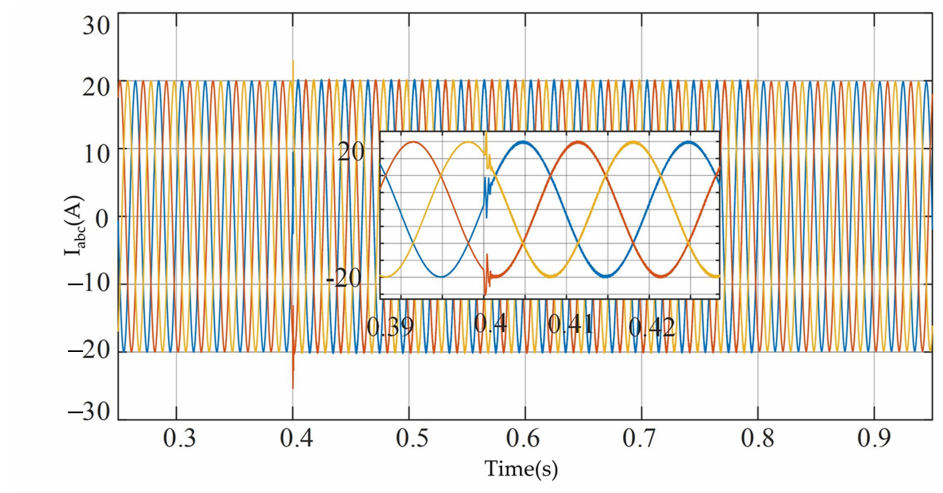
Figure 18. Three-phase current variation situation result during the transition process.